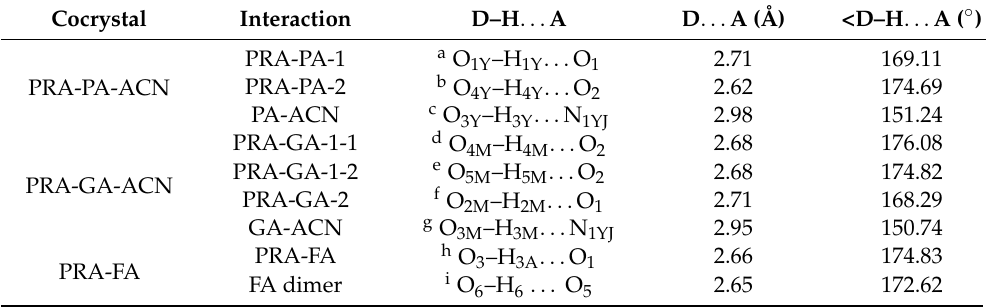
Table 2. Parameters of main hydrogen bonds for cocrystals.